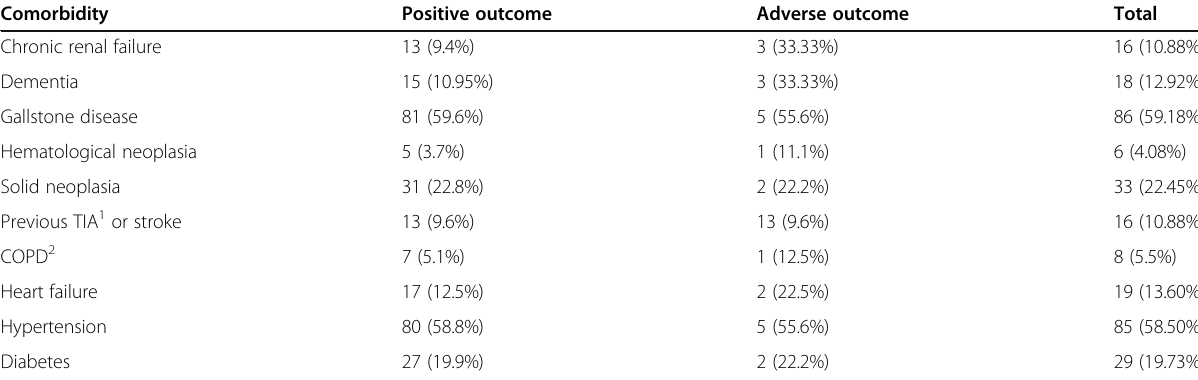
Table 2 Comorbidities in the two groups Comorbidity Positive outcome